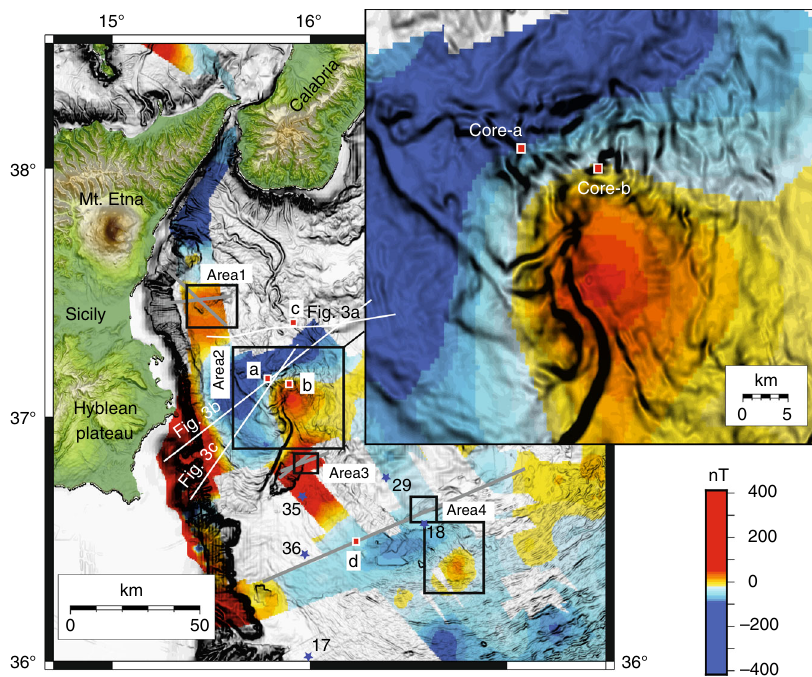
Fig. 2 Magnetic anomaly map derived from this study superimposed over a gray levels bathymetric slope map. The four major areas of mantle diapirism described in this work are indicated (black squares 1 – 4). The inset highlights the rough sea fl oor topography of Area-2, which corresponds to the magnetic anomaly. White lines correspond to MCS data shown in Fig. 3, whereas gray lines are shown in the supplementary material. Blue stars represent heat fl ow measurements from ref. 23 (17: 15.7 ± 1.9 mW m − 2 ; 18: 16.2 ± 2.7 mW m − 2 ; 29: 26.1 ± 5.2 mWm − 2 ; 35: 30.3 ± 5.0 mW m − 2 ; 36: 34.4 ± 4.0 mW m − 2 ). Red squares a – d represent gravity cores described in the manuscript (Fig. 7) and Supplementary Figs. 9 –